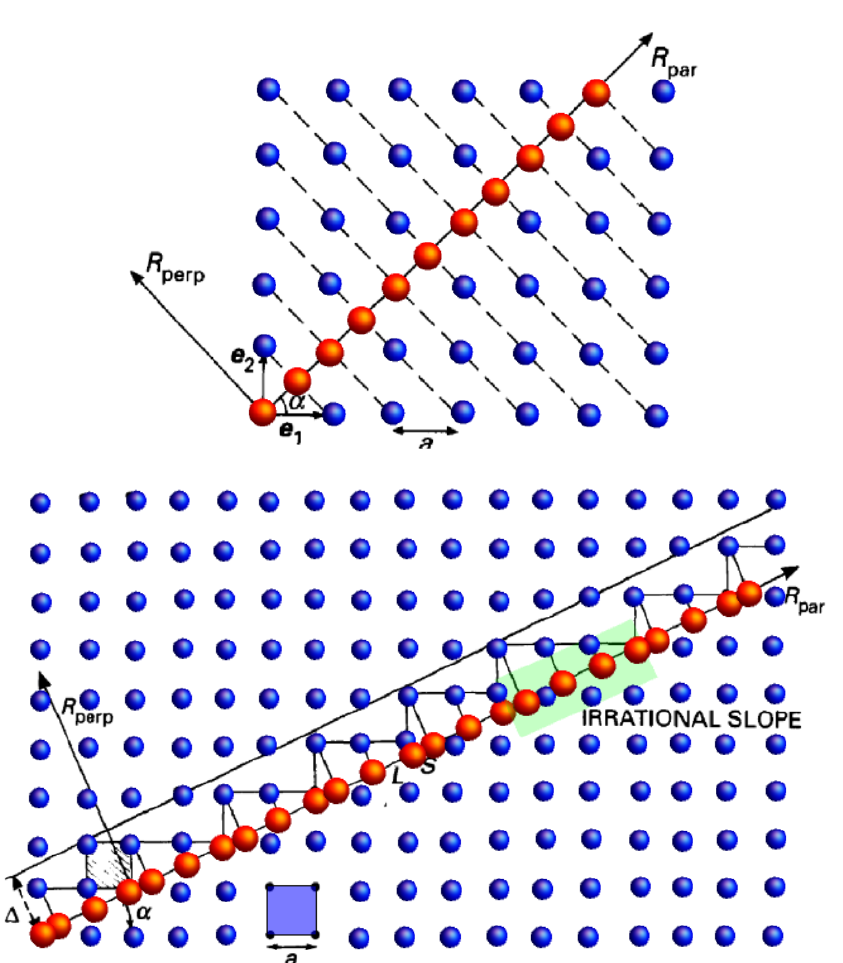
Figure 2: The superspace description for quasicrystals in a 2 D → 1 D example. The blue dots are the positions of the atoms in the extra-dimensional periodic crystal; the red ones are the position of the atoms in the quasicrystal. The periodic 2D lattice has lattice spacing a . The figures are adapted from [ 47 ] . Top: A rational cut producing a periodic 1D crystal. Bottom: An irrational cut producing an aperiodic-crystal made of two lattice sizes L , S incommensurate between